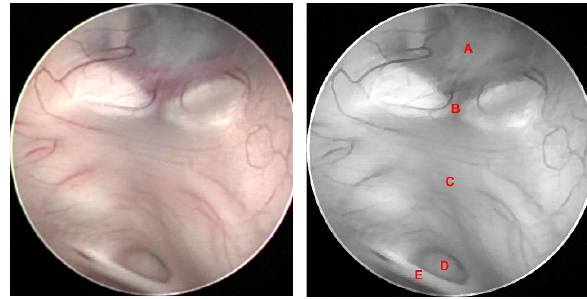
Fig. 13. Tuber cinereum (A), mammillary bodies (B), middle segment (C), cerebral aqueduct (D), posterior commissure (E).